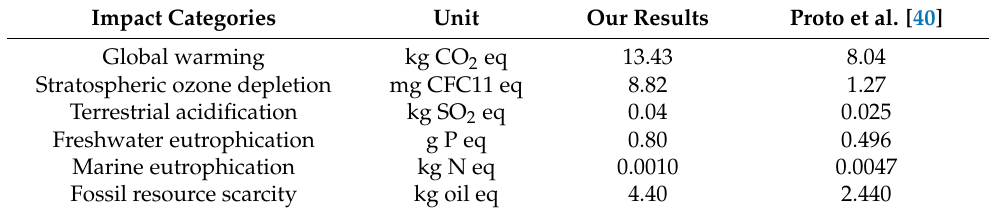
Table 8. Comparison of results for scenario (i) with results for the HS–SK system in Proto et al. [40]. Impact Categories Unit Our Results Global